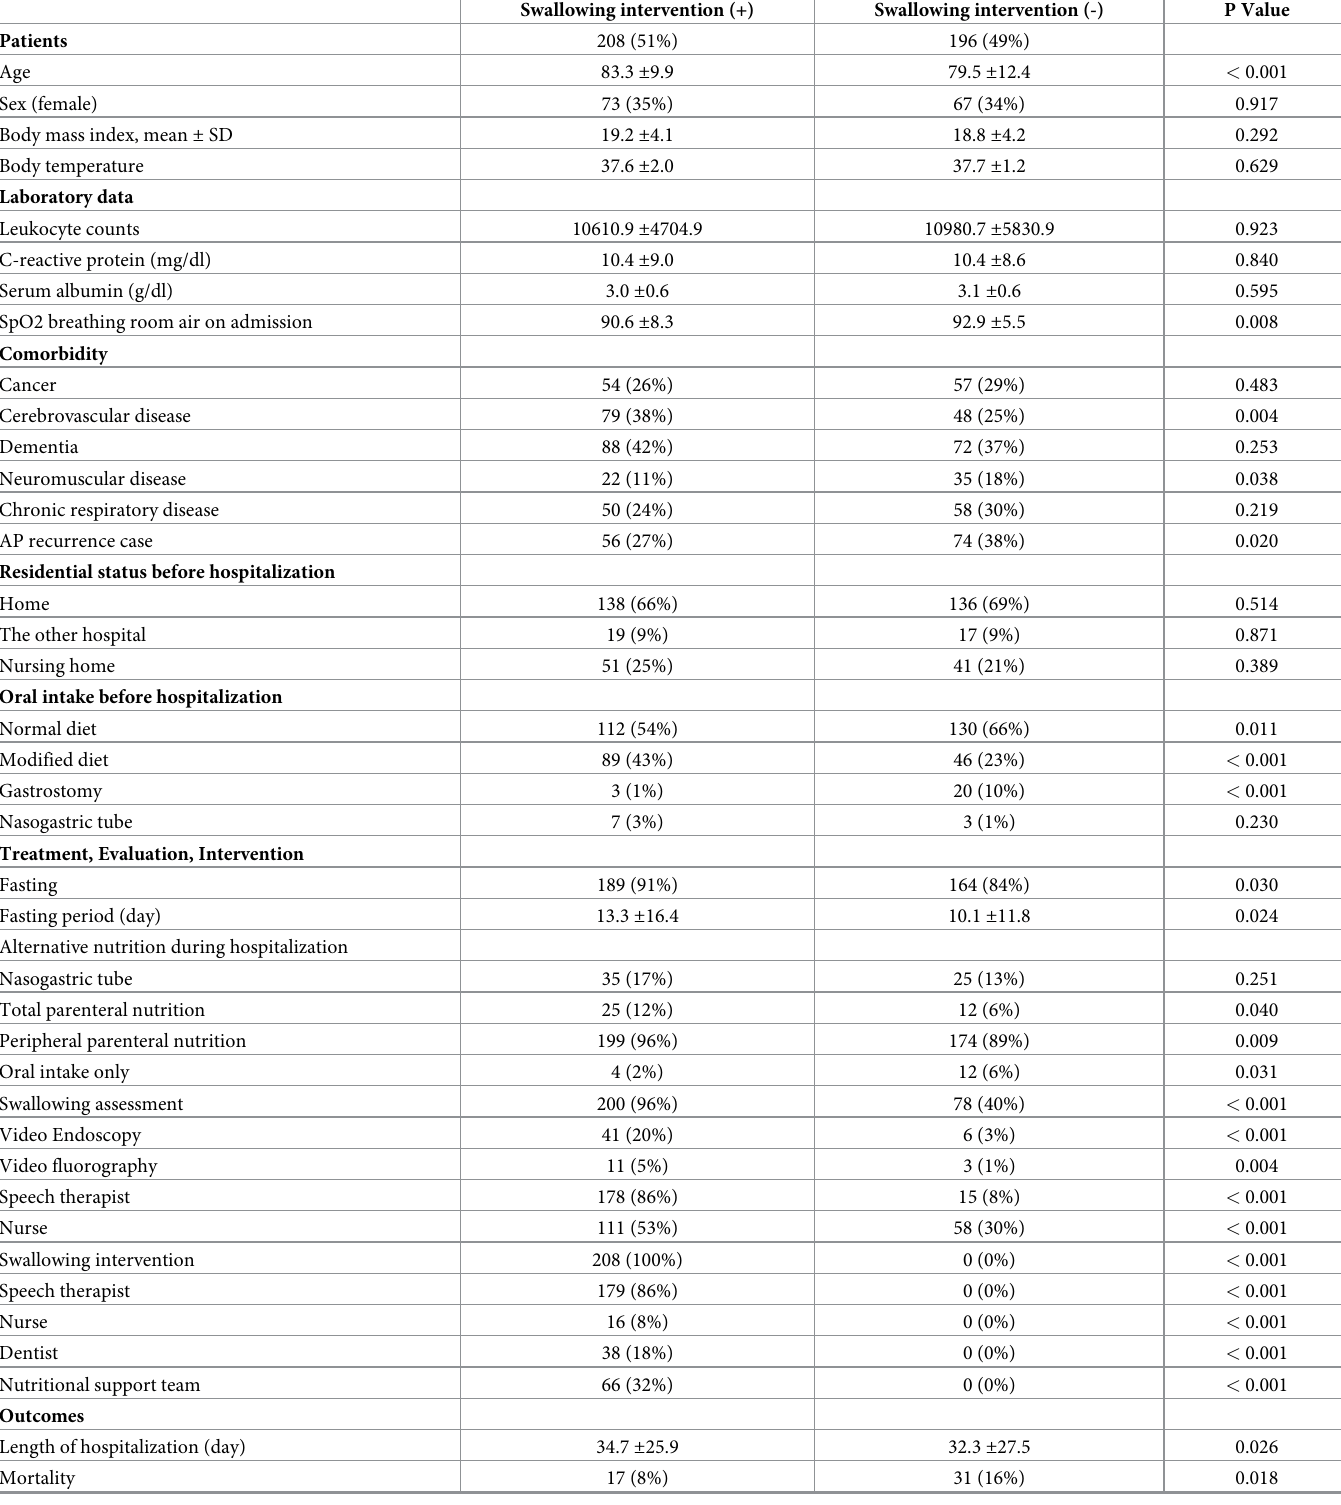
Table 3. Characteristics of aspiration pneumonia patients with swallowing